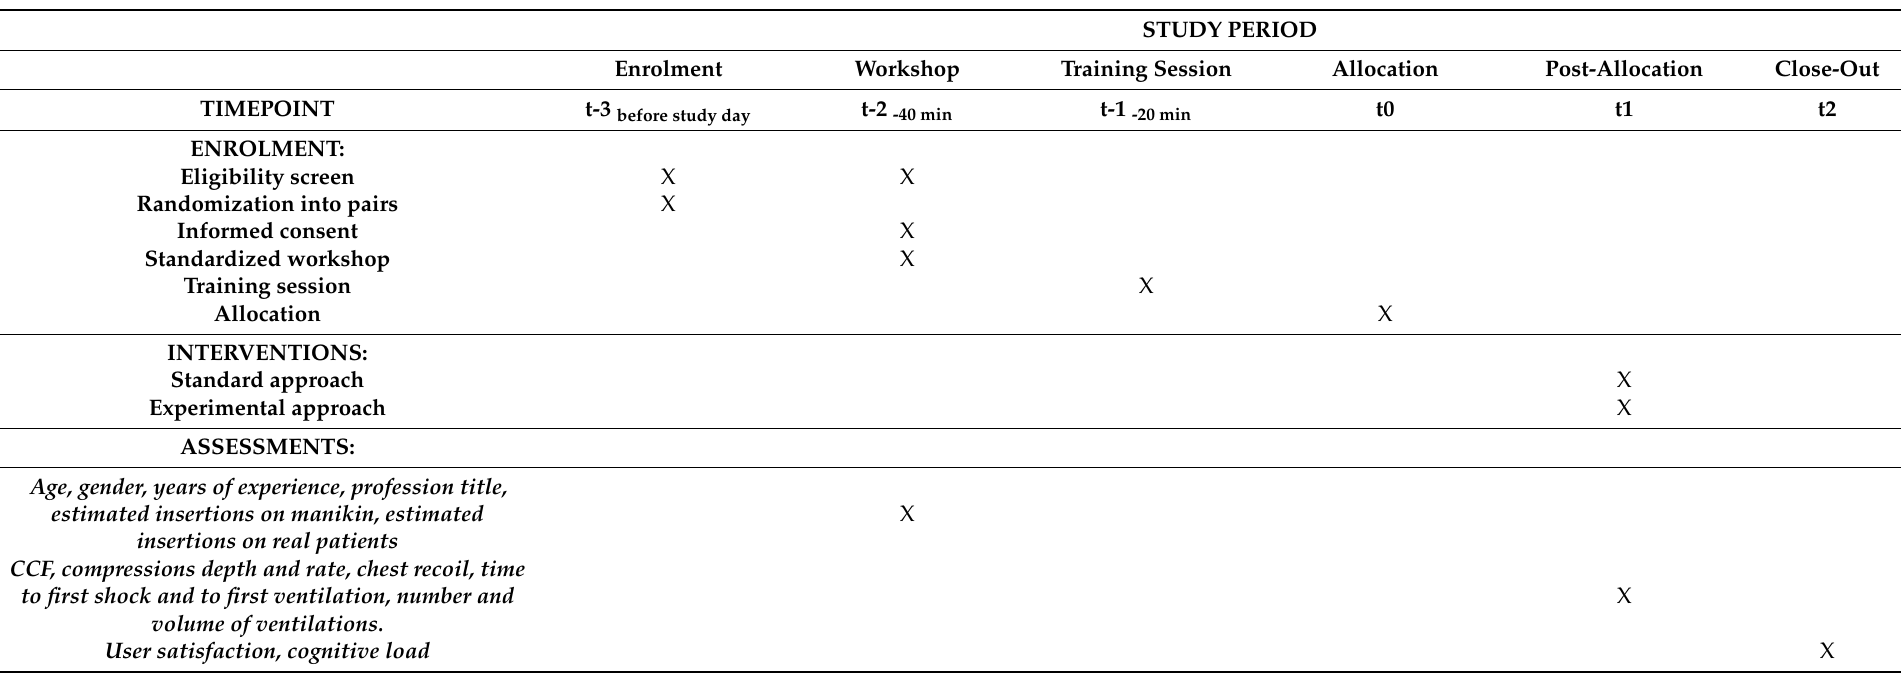
Table 1. Timeline of enrolment, interventions and